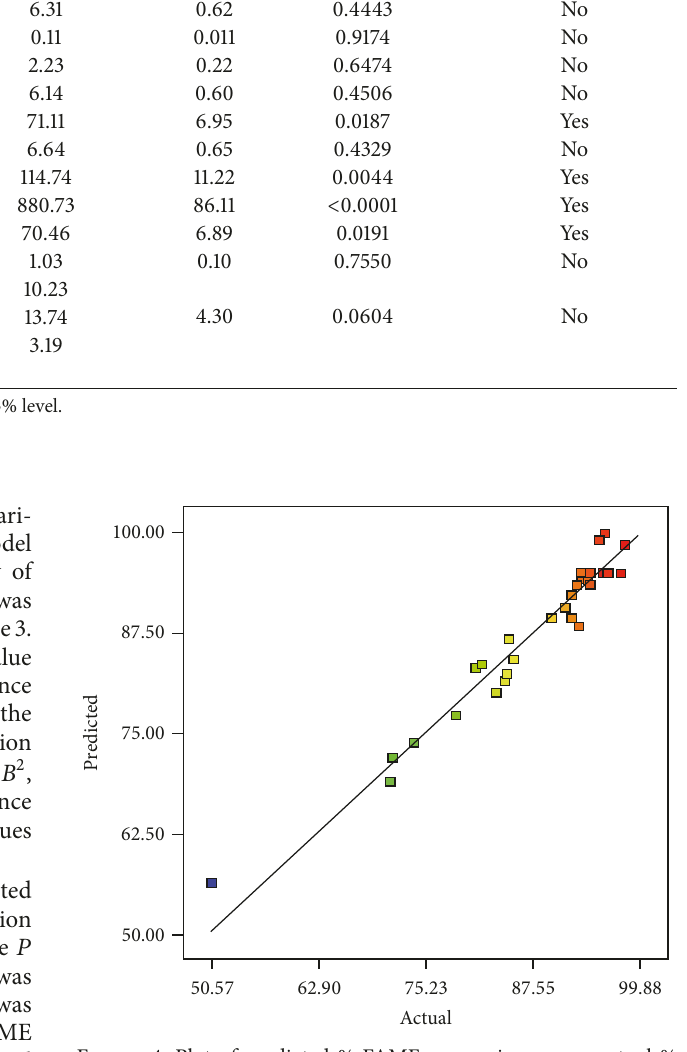
Figure 4: Plot of predicted % FAME conversion versus actual % FAME